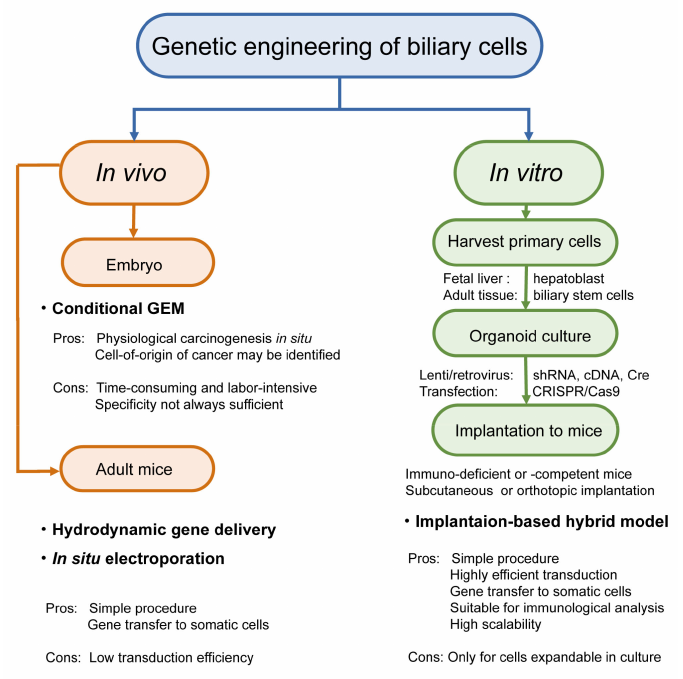
Figure 6. Flow chart for selection of the BTC model. Depending on the purpose of study and affordable efforts, researchers can select the most suitable experimental system for BTC